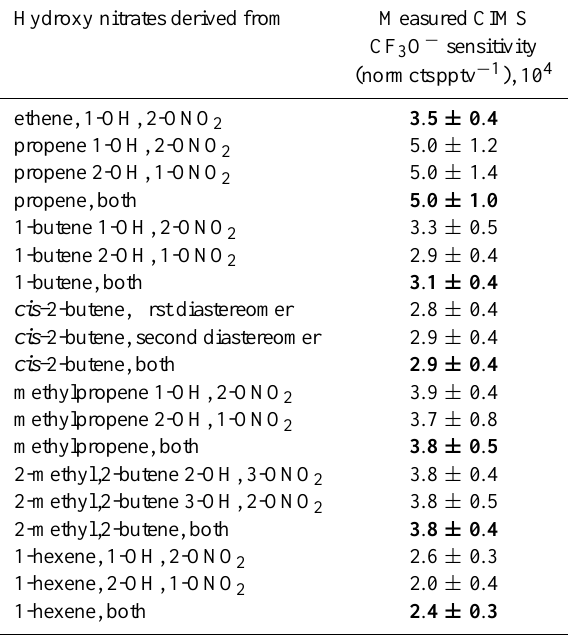
Absolute sensitivities for all isomers were determined by summing all peaks in both the CIMS and TD-LIF, and deriving a sensitivity from the total. Uncertainties (1 σ ) include the 10% uncertainty from the split ratio and absolute NO 2 determination by the TD-LIF. The measured 1-hexene HN sensitivities are lower than other HNs measured in this study. This may reflect precision errors for this one compound, and thus lead to a high biasing in the HN branching of 1-hexene and